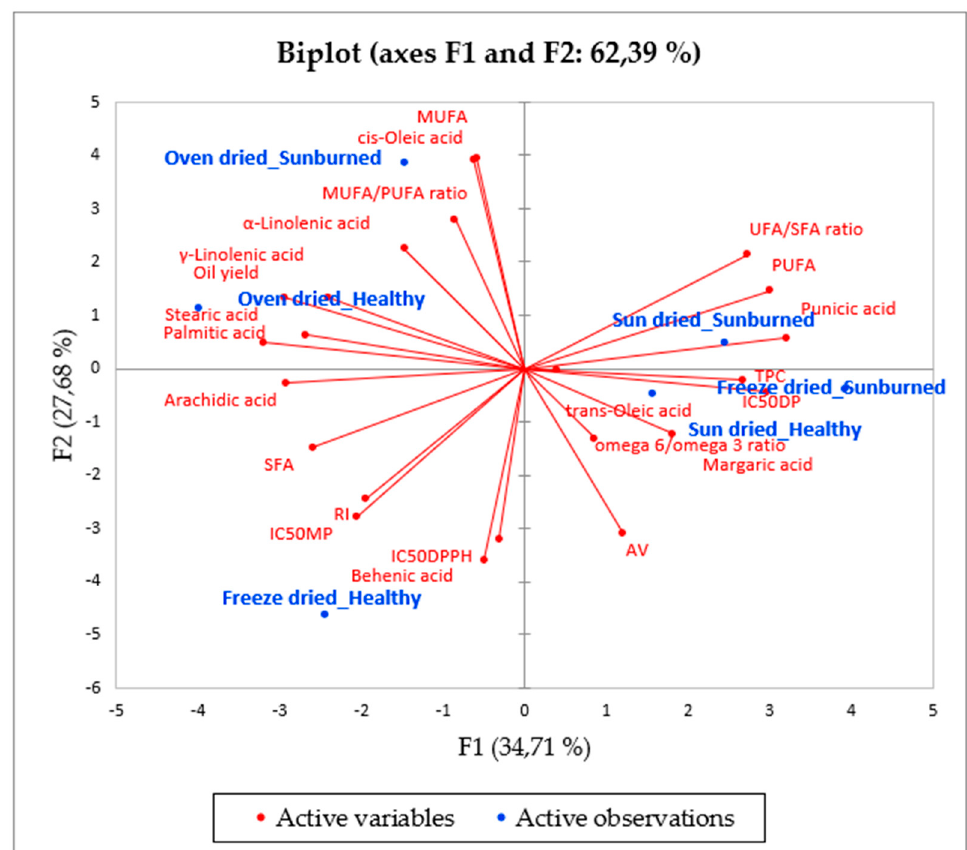
Figure 3. Principal component analysis (PCA) showing the relationship between fruit quality, seed drying method, and the oil chemical properties. TPC: total phenolic content, IC 50 DP: diphenolase, IC 50 MP: monophenolase, IC 50 DPPH, RI: refractive index, AV: anisidine value, IC 50 -50% inhibitory concentration, SFA: saturated fatty acids, MUFA: monounsaturated fatty acids, PUFA: polyunsatu- rated fatty acids, UFA: unsaturated fatty acids.